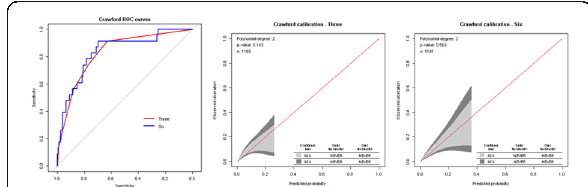
Fig. 1 (abstract P10). Example results from one